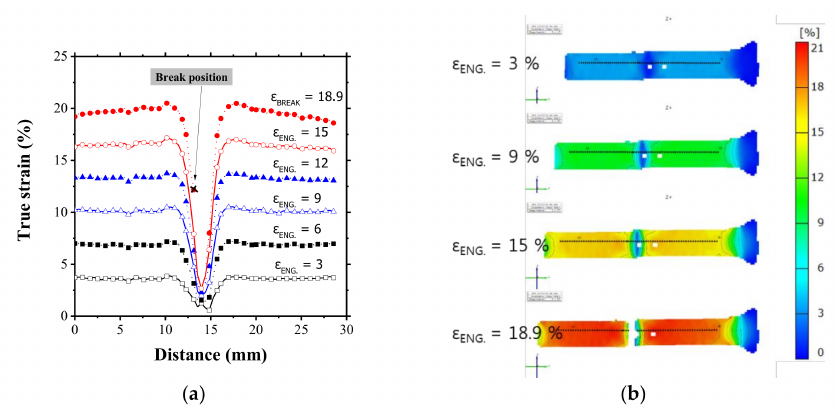
Figure 8. ( a ) Local true strain calculated using DIC program and ( b ) measurement positions and map of true strain, which depends on engineering strain ( (cid:101) ENG ) from 3% to 18.9%. Specimen was prepared